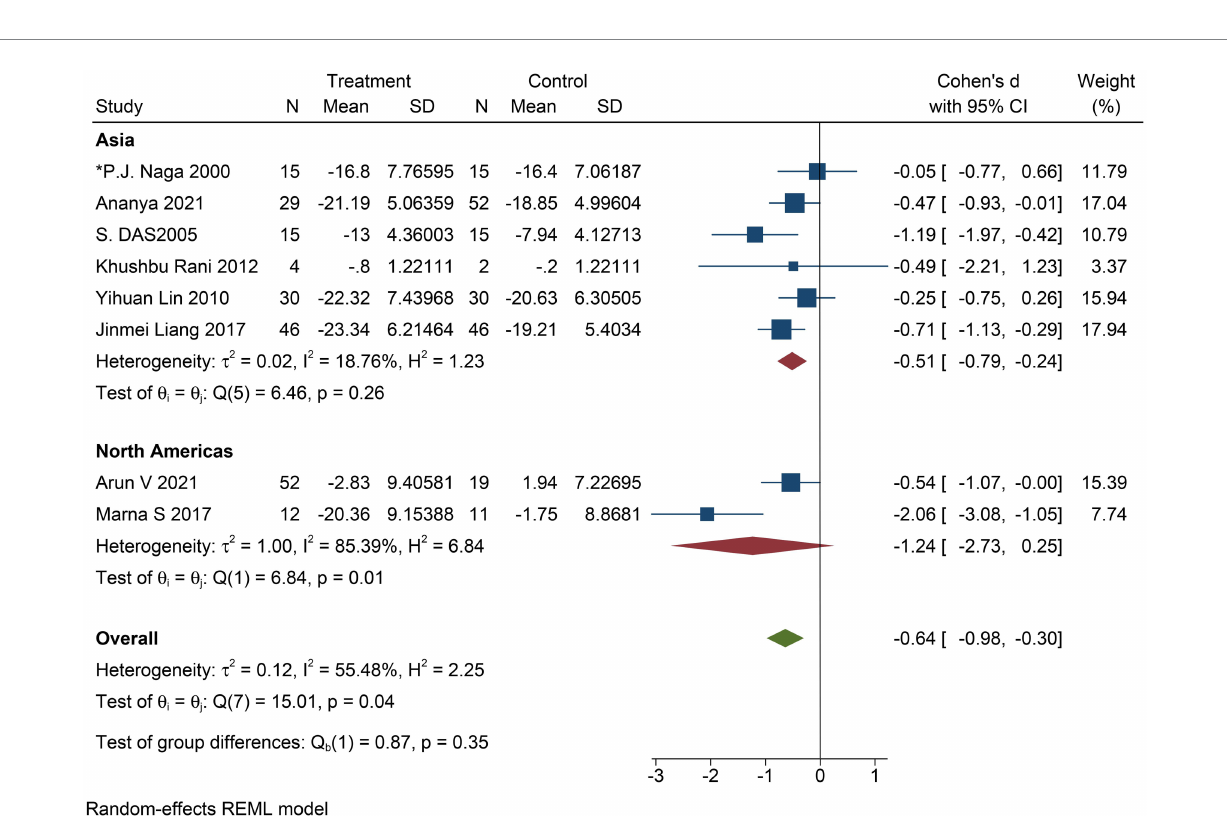
FIGURE 10 Forest plot of subgroup analysis regarding the region of study.